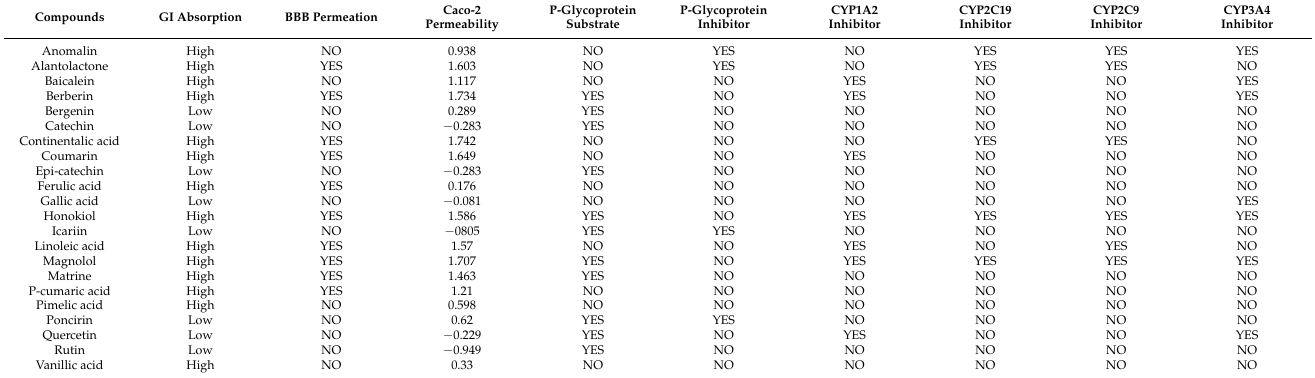
Table 3. The pharmacokinetic parameter assessment of the selected compounds using the computa- tional